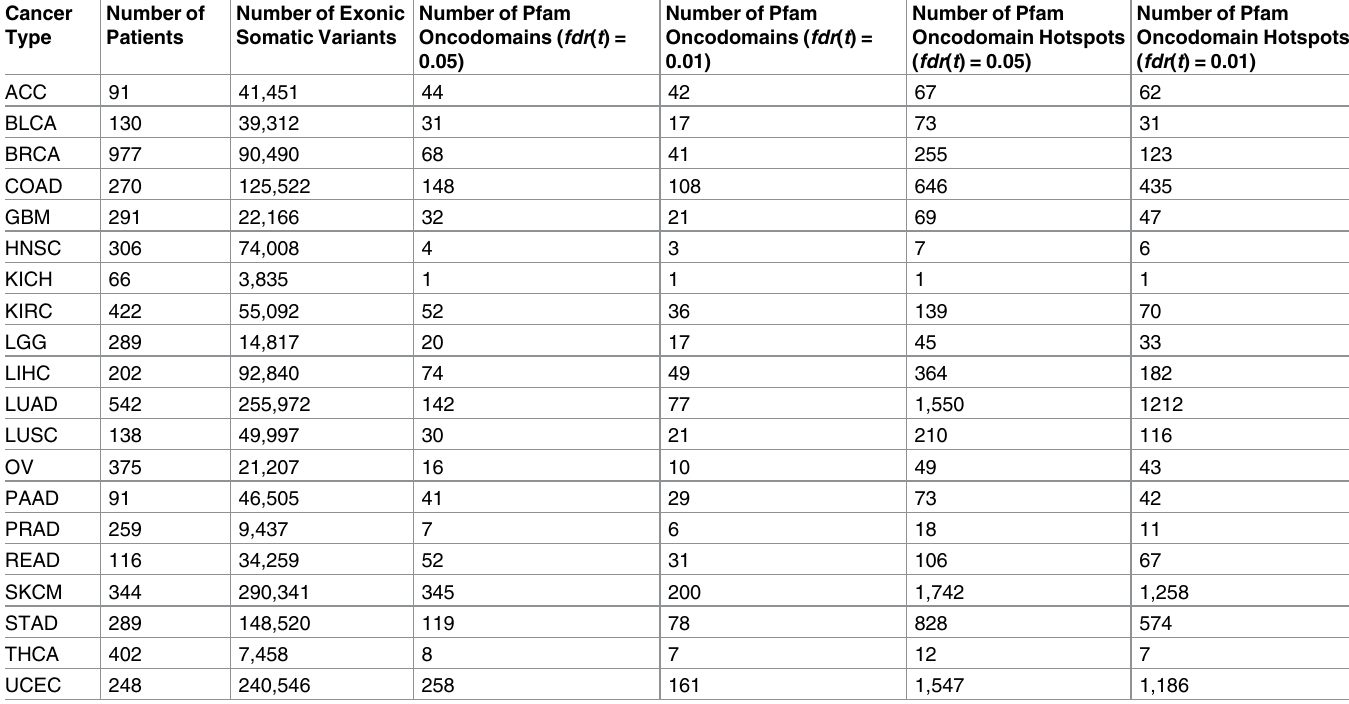
Table 1. Number of patients, somatic variants, oncodomains, and oncodomain hotspots for each cancer type. Cancer Number of Type Patients